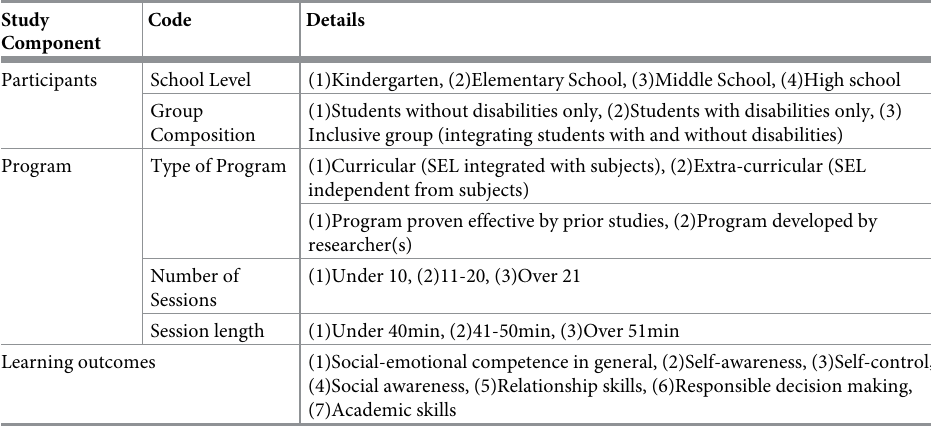
Table 1. A coding system for effect size